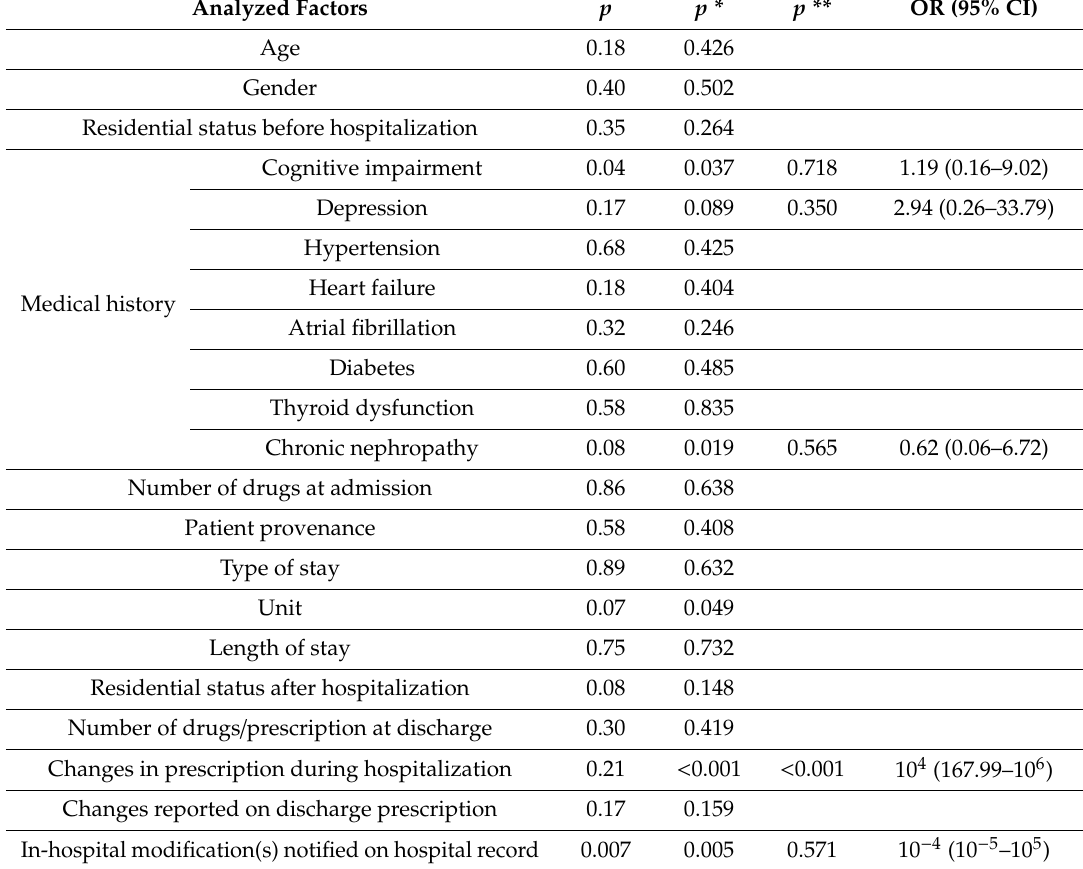
Table 4. Factors influencing prescription changes at 6 weeks, after univariate, bivariate and multivariate (logistic regression) analyses.